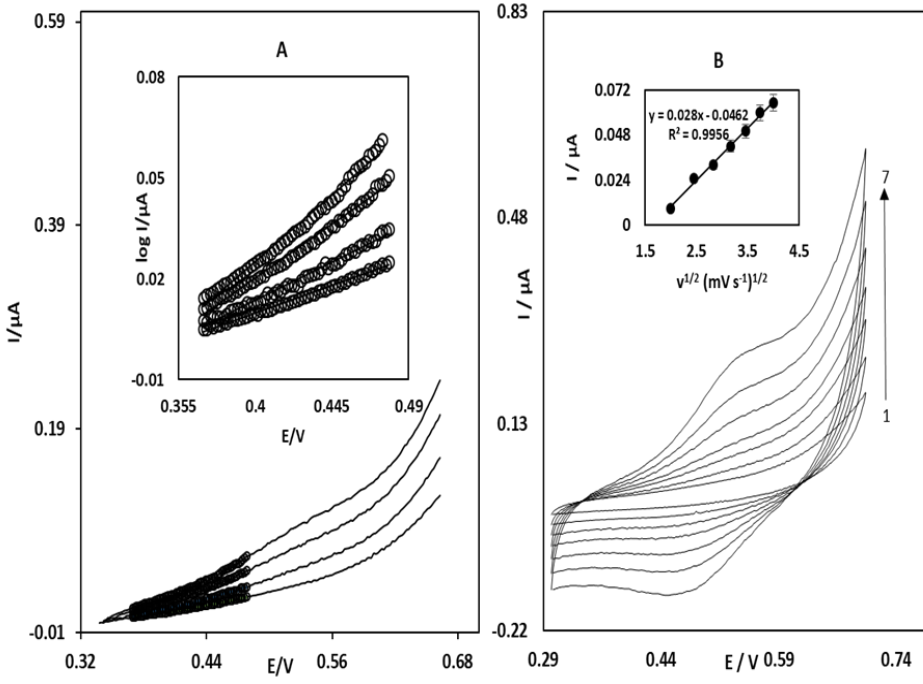
Figure 4. Linear sweep voltammograms of OB/SNPs/GO/SPE in 0.l M phosphate buffer solution pH = 7.0 containing 0.1 mM STR at different scan rates (The numbers 1–7 correspond to 4-16 mV·s –1 ). Inset B shows variation of the electrocatalytic current versus the square root of the scan rate.